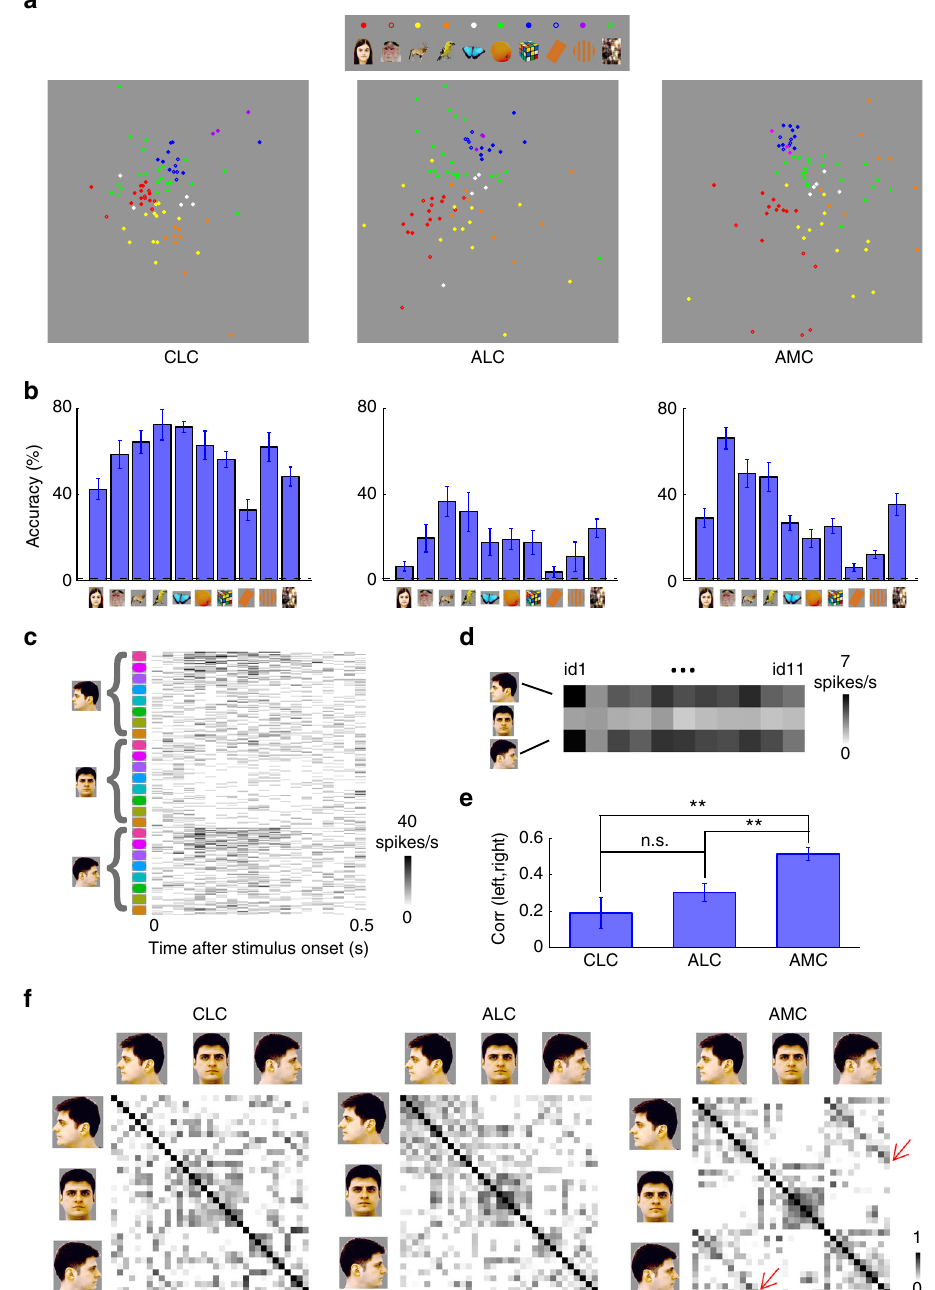
Fig. 4 Representation of object shape by color-selective neurons in color patches. a Neural representation of object shapes in the activities of color- selective neurons for three patches, shown as two-dimensional MDS plots. Responses to each object shape were averaged across 8 hues. b Decoding accuracies for identifying one object out of 82 objects based on population responses in three color patches, averaged across object identities within each category (see Methods). Error bars represent s.e. Dashed lines indicate chance level (1/82 = 1.2%). c Raster plot showing responses of an AMC neuron to colored human faces of 11 identities at three views: frontal, left-, and right-pro fi le (Supplementary Fig. 2i). d The same response in c averaged across 8 hues, showing strong correlation between left- and right-pro fi les, but not between frontal and pro fi le views. e Correlation between responses to left and right pro fi le views was computed across identities for each cell. Mean and s.e. of all neurons in three patches are plotted ( n = 26 CLC cells; n = 40 ALC cells; and n = 44 AMC cells). Student ’ s t -test was used to determine statistical signi fi cance between patches (* p < 0.05, ** p < 0.01). f Population similarity matrices of 11 identities ×3 views in three color patches. The paradiagonal stripes in AMC indicate high correlation between responses to mirror-symmetric views of the same identity (red